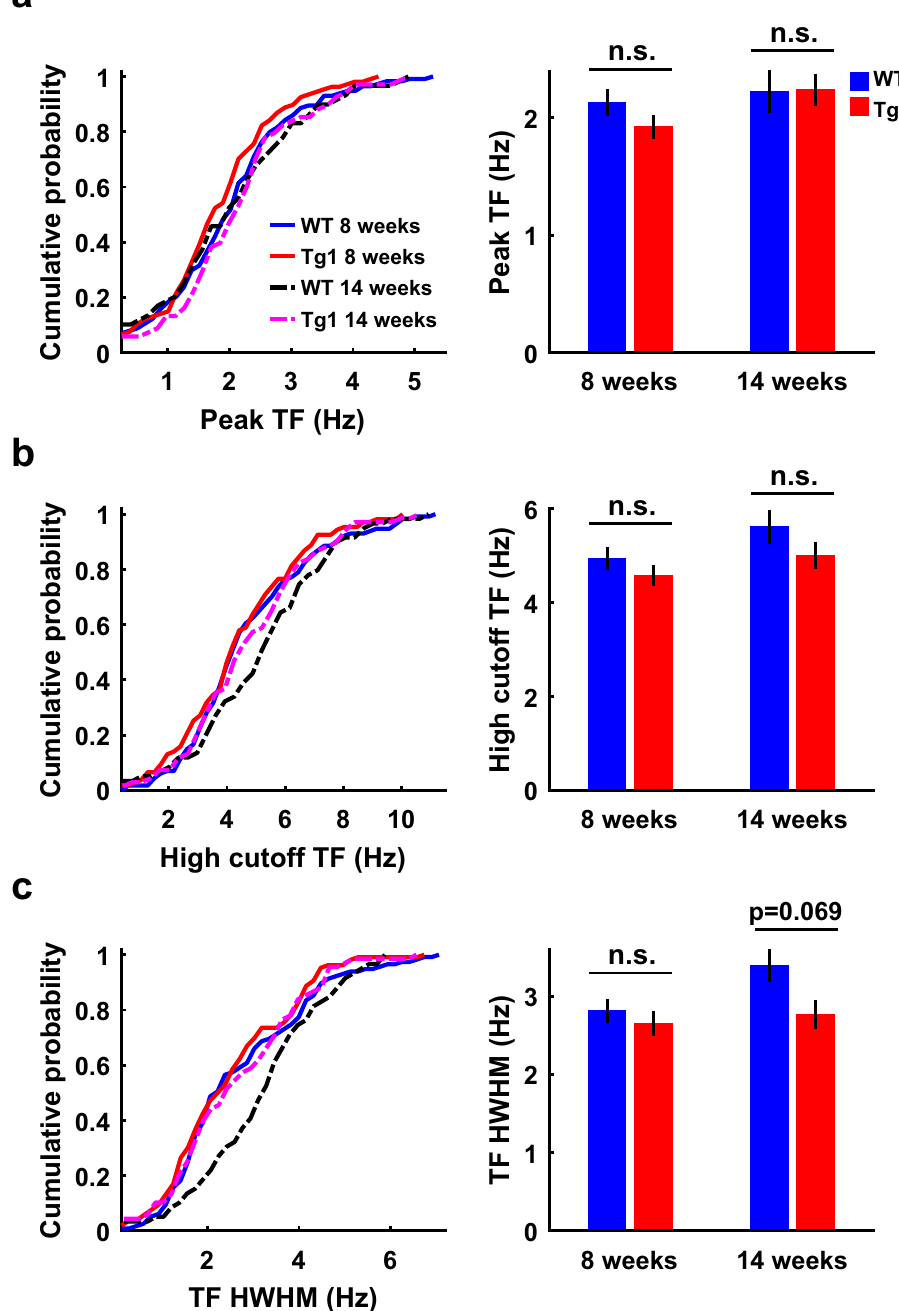
Figure 2. Comparison of temporal frequency preference between V1 neurons in WT and Tg1 mice. ( a ) Cumulative histograms of preferred TFs (left) and mean preferred TFs (right) for V1 neurons in WT and Tg1 mice. ( b ) Cumulative histograms of high cutoff TFs (left) and mean high cutoff TFs (right) for V1 neurons in WT and Tg1 mice. ( c ) Cumulative histograms of HWHMs of TF tunings (left) and mean HWHMs (right) for V1 neurons in WT and Tg1 mice. Error bars, ± s.e.m., P > 0.05, two-way ANOVA followed by Tukey’s multiple comparison test. n = 115 neurons from 16 WT mice at 8 weeks, n = 60 neurons from 11 WT mice at 14 weeks, n = 107 neurons from 17 Tg1 mice at 8 weeks, n = 68 neurons from 17 Tg1 mice at 14